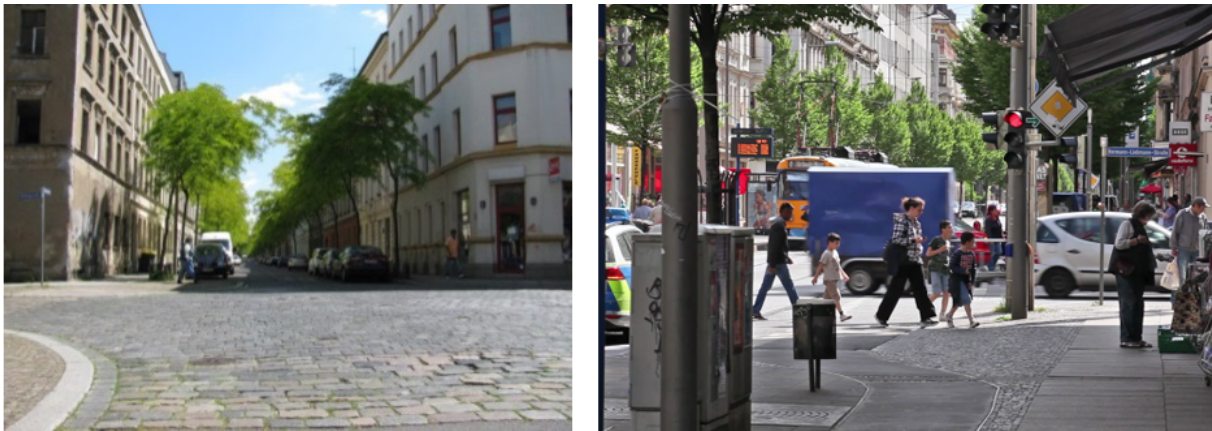
Figure 1. The old built-up area of Leipzig’s inner east (left) and the central axis Eisenbahnstrasse (right). Source: A. Haase and EU project